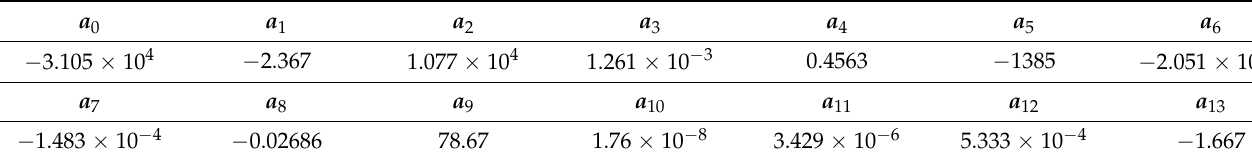
Table 10. Comparison between the calculated results of the prediction model and the experimental results for the transfer period of the surface wave.